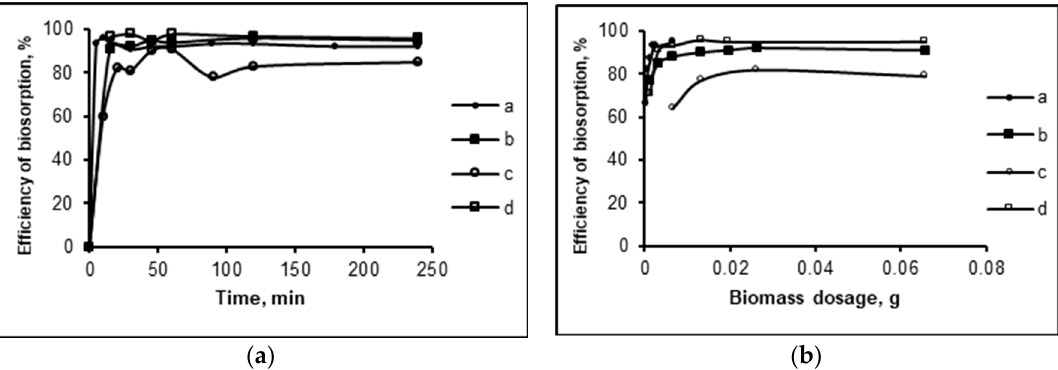
Figure 2. Dependency of the efficiency of biosorption of Pt (0.1 mg L − 1 ) and Pd (0.075 mg L − 1 ) at optimal pH conditions on Saccharomyces sp. and Aspergillus sp. on ( a ) contact time ( b ) biosorbent mass (contact time 45 min); a—Pt(IV) on yeast; b—Pt(IV) on fungi; c—Pd(II) on yeast; d—Pd(II) on fungi.